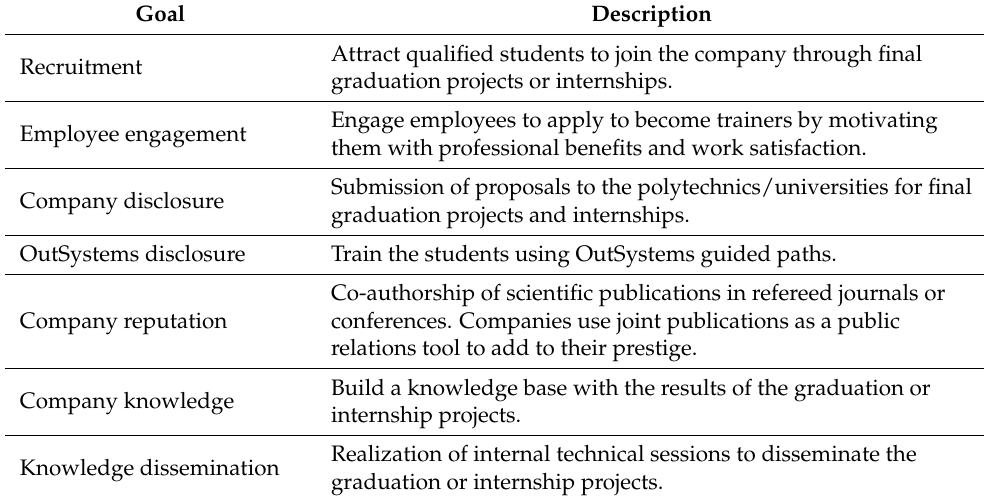
Table 2. Tangible goals for the industry-polytechnic/university